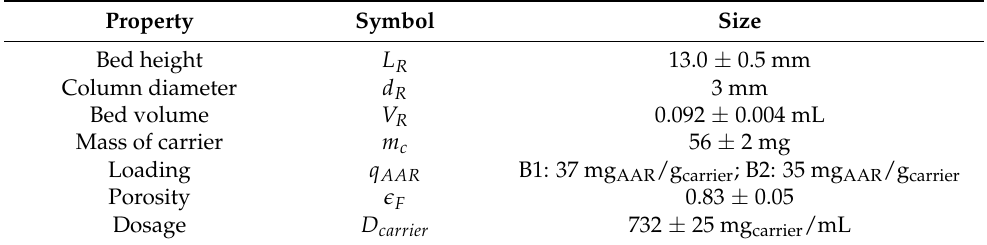
Table 6. Properties of fixed-beds (from two batches of immobilized AAR, B1 and B2).